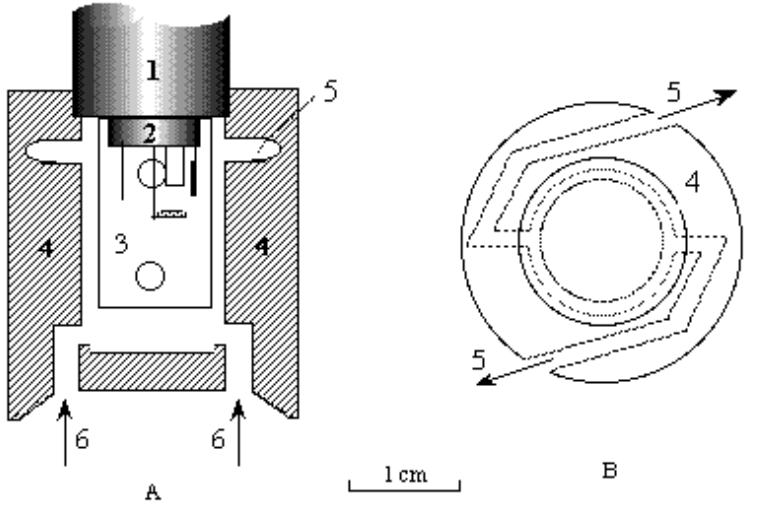
Figure 1. Schematic of ECL sensor: A. side views of the sensor; B. top view of the sensor. 1. fixed stick filled with a sensor probe; 2. sensor probe; 3. internal electrolytic cell; 4. sensor body; 5. outlet of a sample solution; 6. inlet of a sample solution.